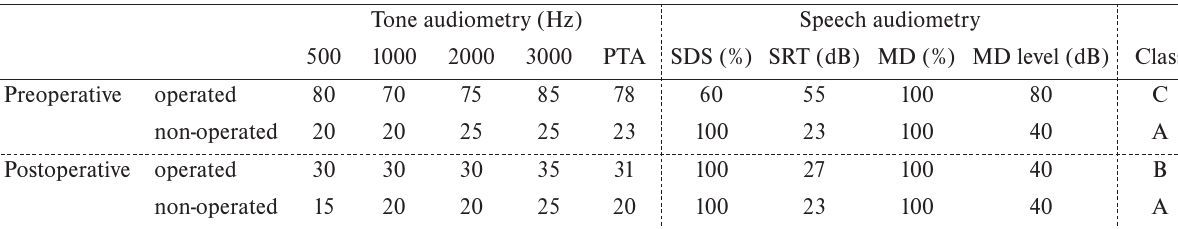
Table 1. Comparison of preoperative and postoperative audiometry.